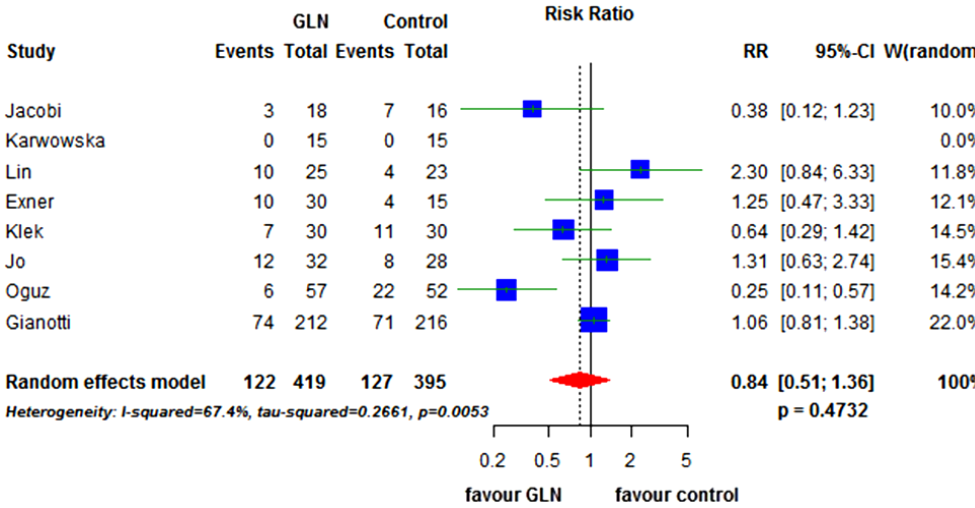
Figure 3. Funnel plot for mortality ( A ), overall morbidity ( B ), infectious morbidity ( C ) and length of in-hospital stay after operation (LOS) ( D ). For each study, the estimated effect measure is plotted on the x-axis and its standard error on the y-axis.